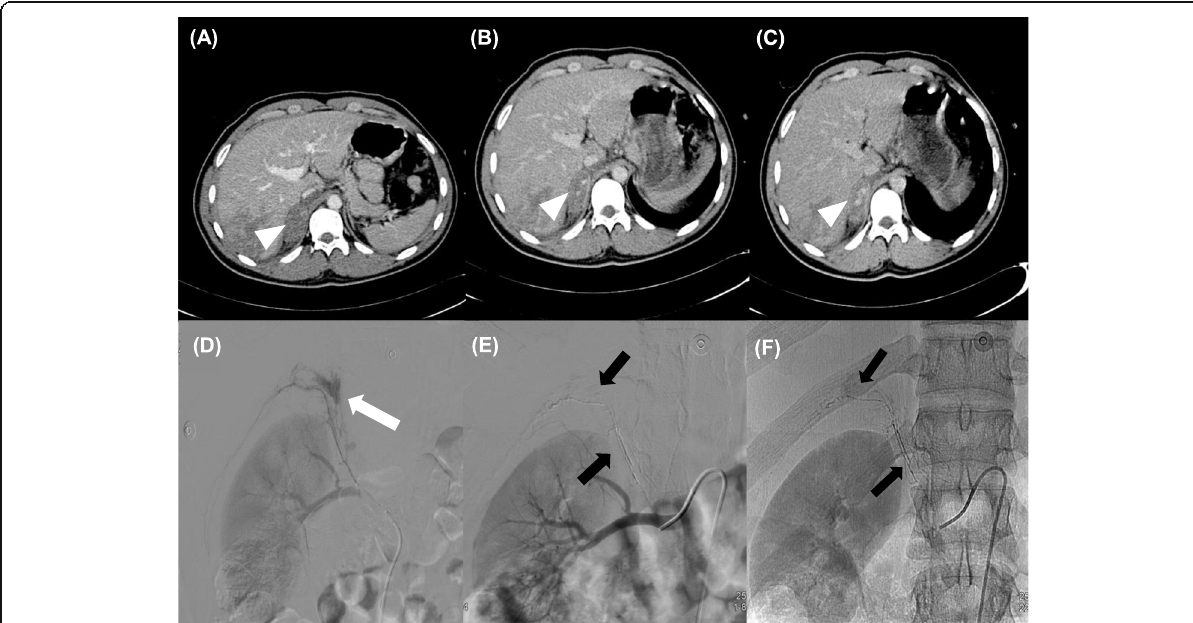
Fig. 3 ( a, b, c ) CT image venous phase ( a ) and arterial phase ( b, c ) after endovenous contrast injection, depicting contrast deposition inside the right adrenal gland (white arrowhead). ( d ) DSA with injection right renal artery showing contrast extravasation (white arrow). ( e ) DSA with injection right adrenal artery showing glue cast (black arrow) in a subtracted image in the adrenal territory after embolization with complete superseletiva exclusion of the injured vessel from the circulation. ( f ) Subtraction image showing glue cast (black arrow)